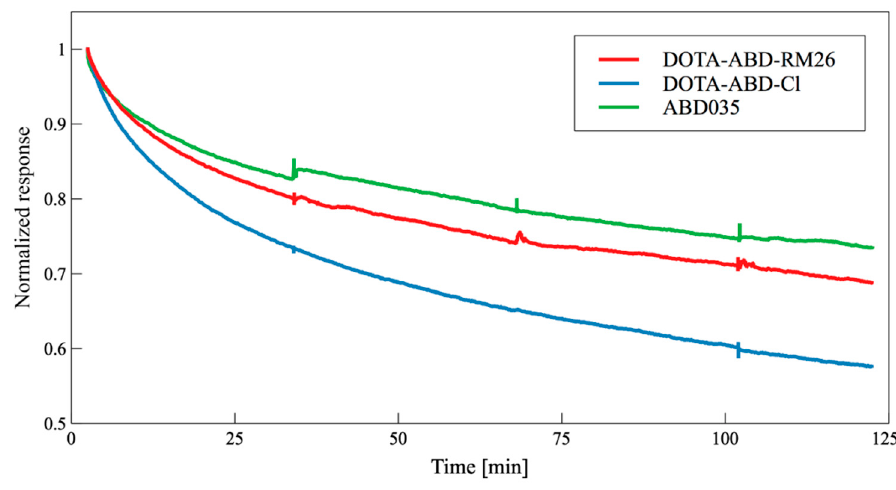
Figure 3. Surface plasmon resonance (SPR) sensorgrams illustrating the relative responses of DOTA-ABD-RM26, DOTA-ABD-Cl and ABD035 binding to HSA at 200 nM. Responses are normalized to the starting point of the dissociation to allow for comparison of dissociation phases for the three constructs. Table 2. Kinetic constants for ABD variants binding to human serum albumin (HSA) determined by SPR.